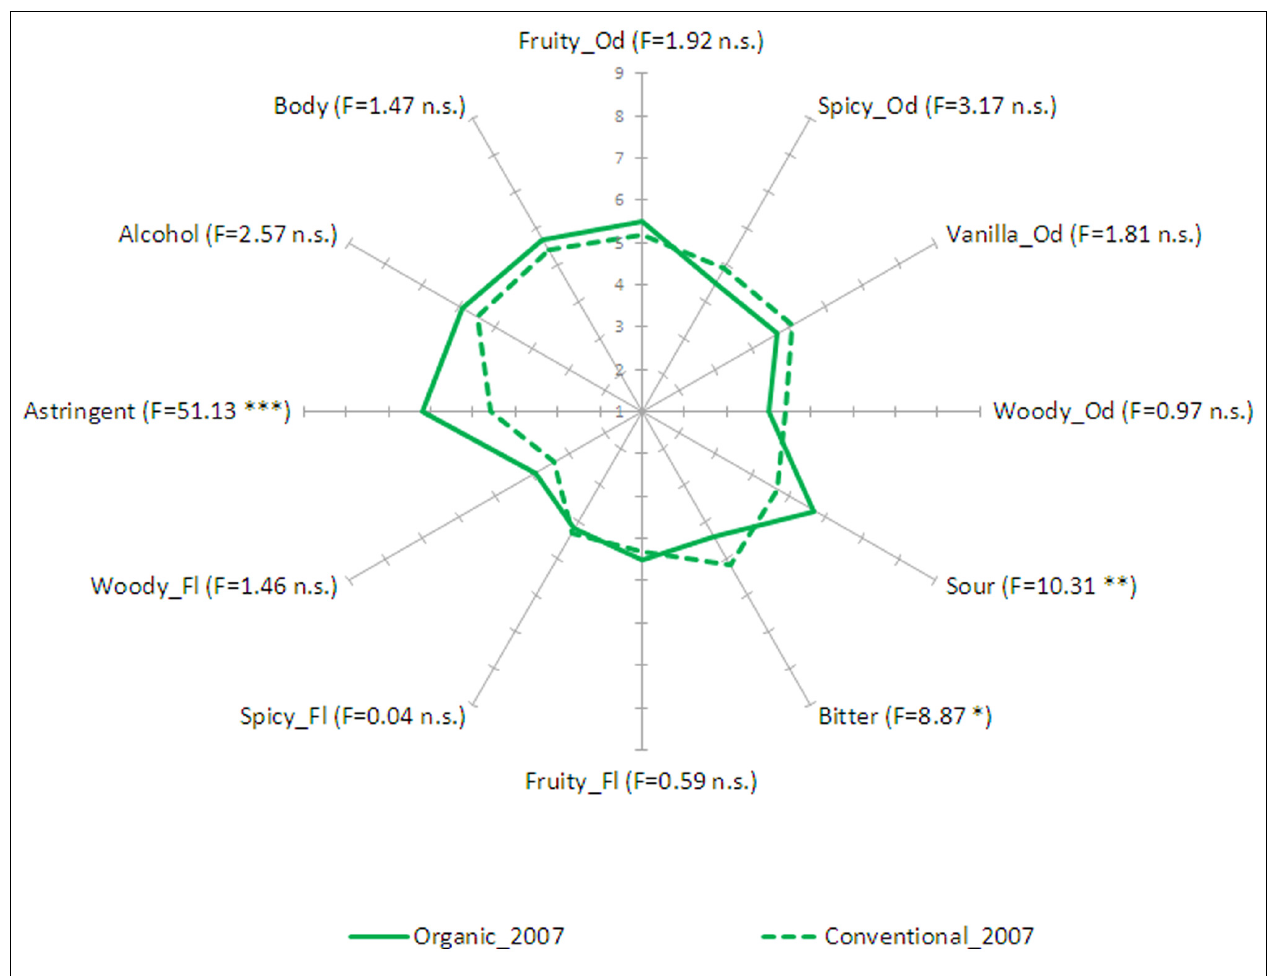
FIGURE 1 | Descriptive analysis results: mean values for each sensory descriptor by method of production (organic vs. conventional) for vintage 2007. For each descriptor the relevant significance is reported (*** p < 0.001, ** p < 0.01, * p <